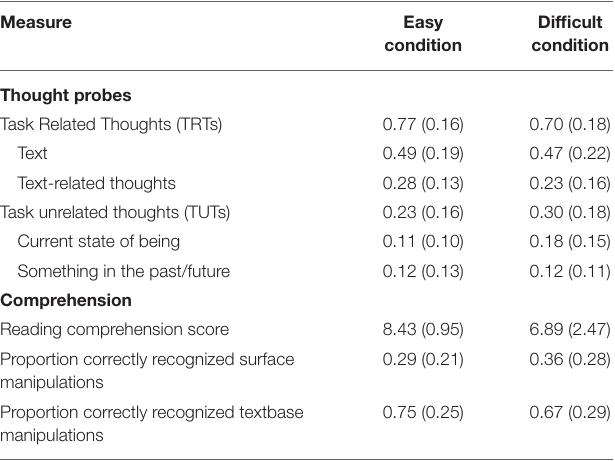
TABLE 2 | Mean proportion of mind wandering, and comprehension scores for easy and difficult text condition.